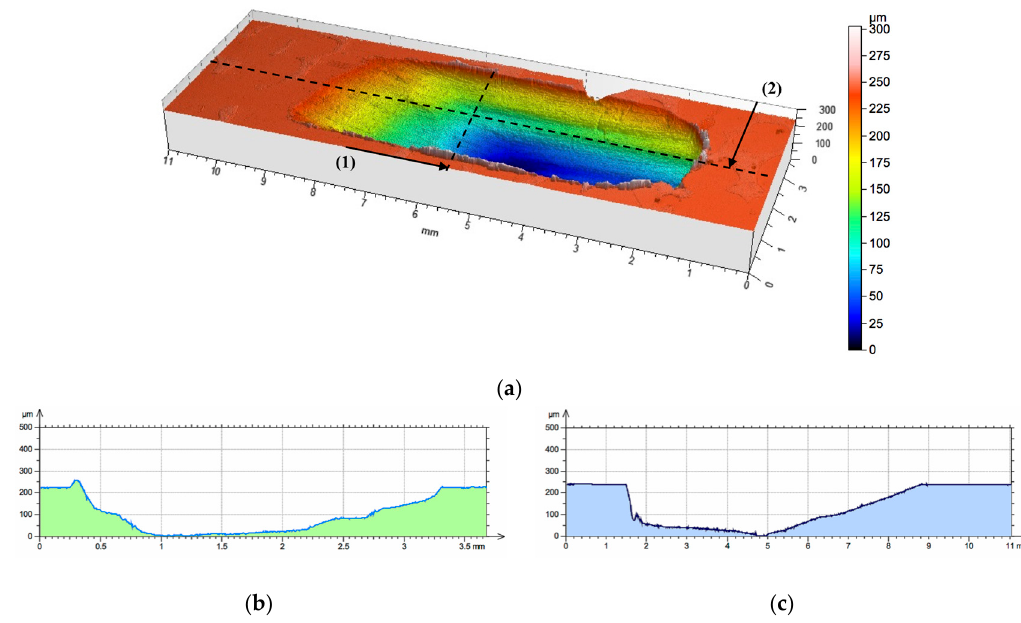
Figure 11. The surface geometry of the AlSi12/Al 2 O 3 _1 composite layer (P1) after working with cast iron pin: ( a ) view of wear track; ( b ) roughness distribution across to the friction direction on line (1); ( c ) roughness distribution along the friction direction on line (2).